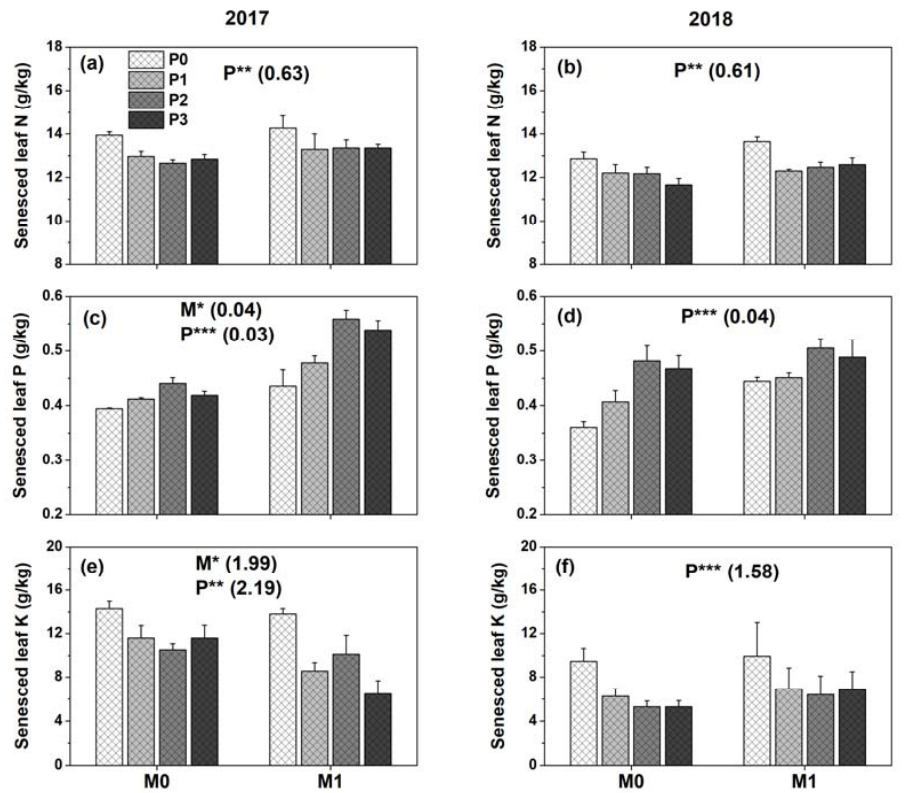
Figure 3. Effect of film mulch (M) and P fertilization (P) on concentrations in senescent leaves of ( a , b ) N, ( c , d ) P, and ( e , f ) K in 2017 and 2018. M0P0, M0P1, M0P2, M0P3, M1P0, M1P1, M1P2, and M1P3 represent no mulch (M0) and mulch (M1) with four levels of P (P0, P1, P2, and P3), respectively. ***, p ≤ 0.001; **, p ≤ 0.01; *, p ≤ 0.05. Numbers in parentheses are LSD values among treatments ( p = 0.05). Error bars show one standard error of the mean.